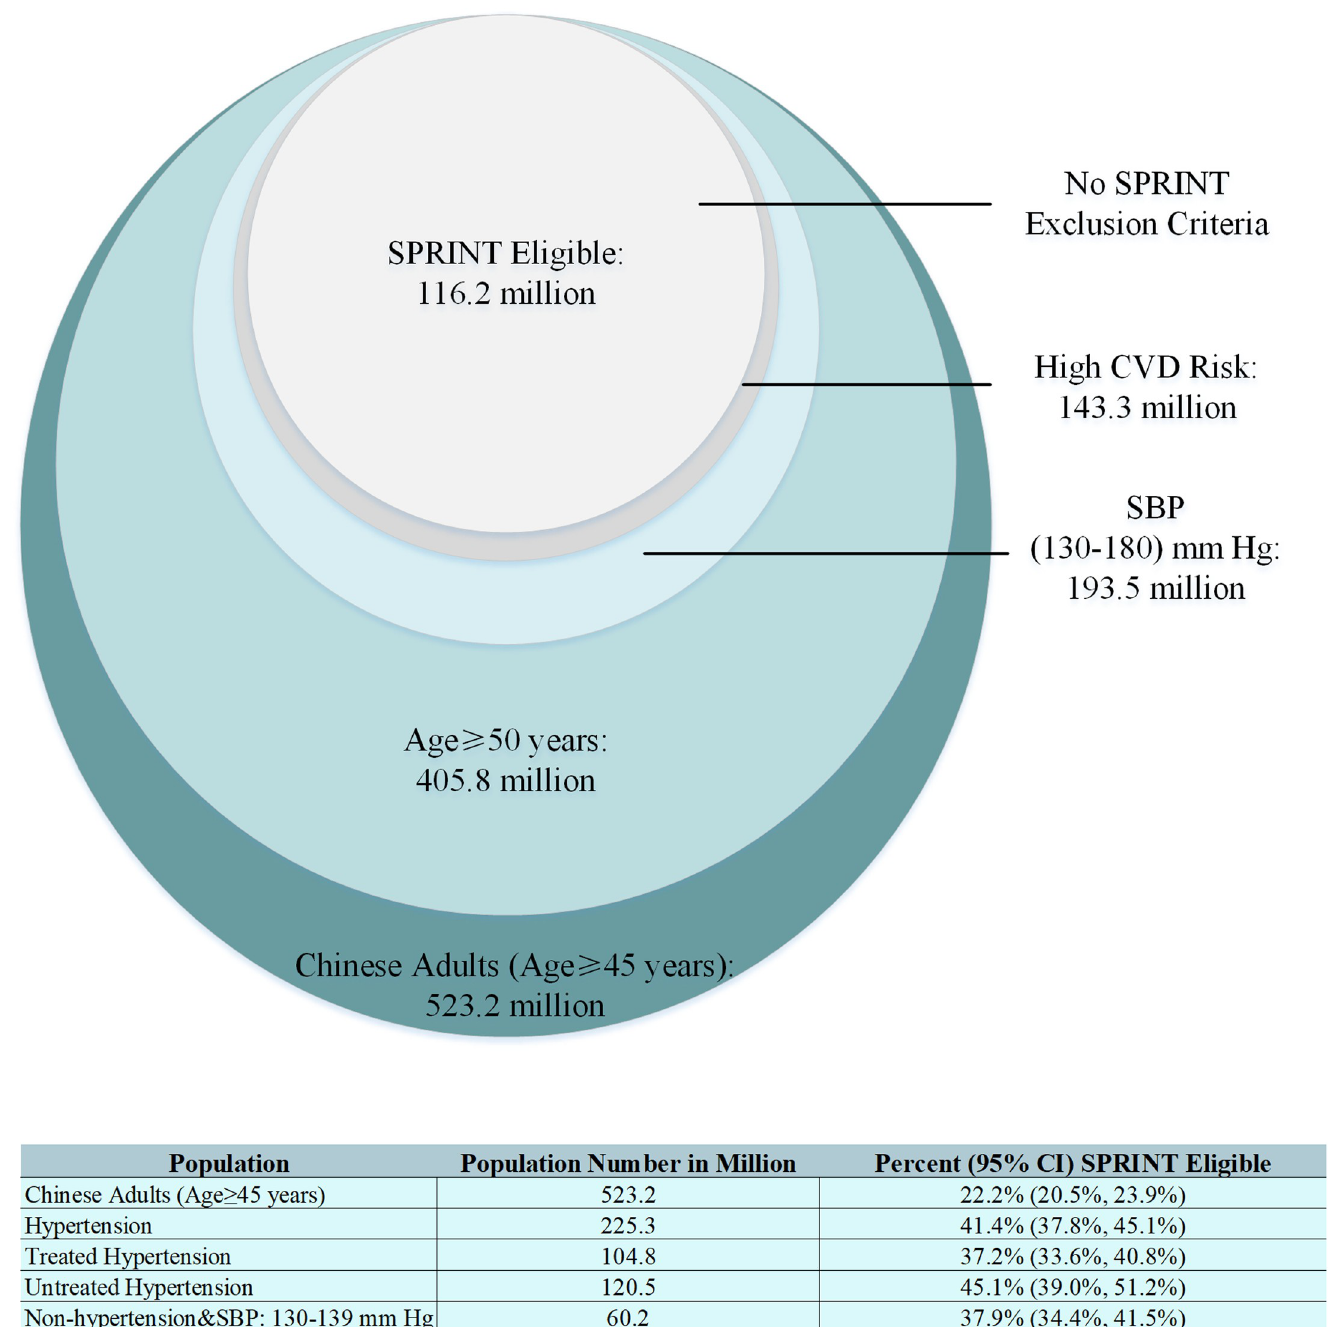
Fig 2. Number of Chinese adults (age � 45 years) meeting each sequential SPRINT eligibility criterion. The circles are proportional to the population sizes. Hypertension defined as SBP � 140 mm Hg or diastolic blood pressure � 90 mm Hg or taking antihypertensive medication. CI, confidence interval; CVD, cardiovascular disease; SBP, systolic blood pressure; SPRINT, Systolic Blood Pressure Intervention Trial.